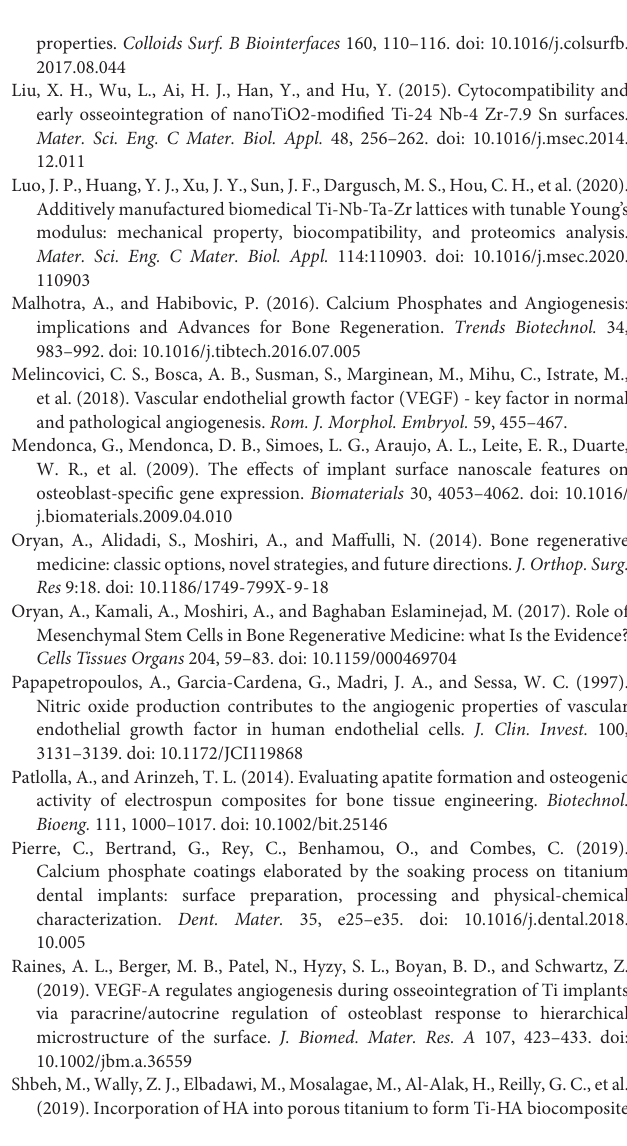
Supplementary Figure 1 | Energy-dispersive X-ray total spectrum of the samples. Supplementary Figure 2 | X-ray diffraction pattern of the samples. Supplementary Table 1 | Primer sequences for